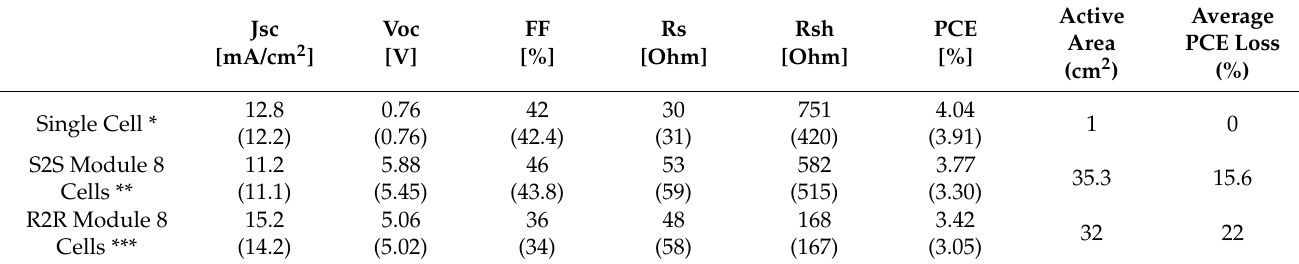
Table 3. Electrical characteristics of the OPV devices and